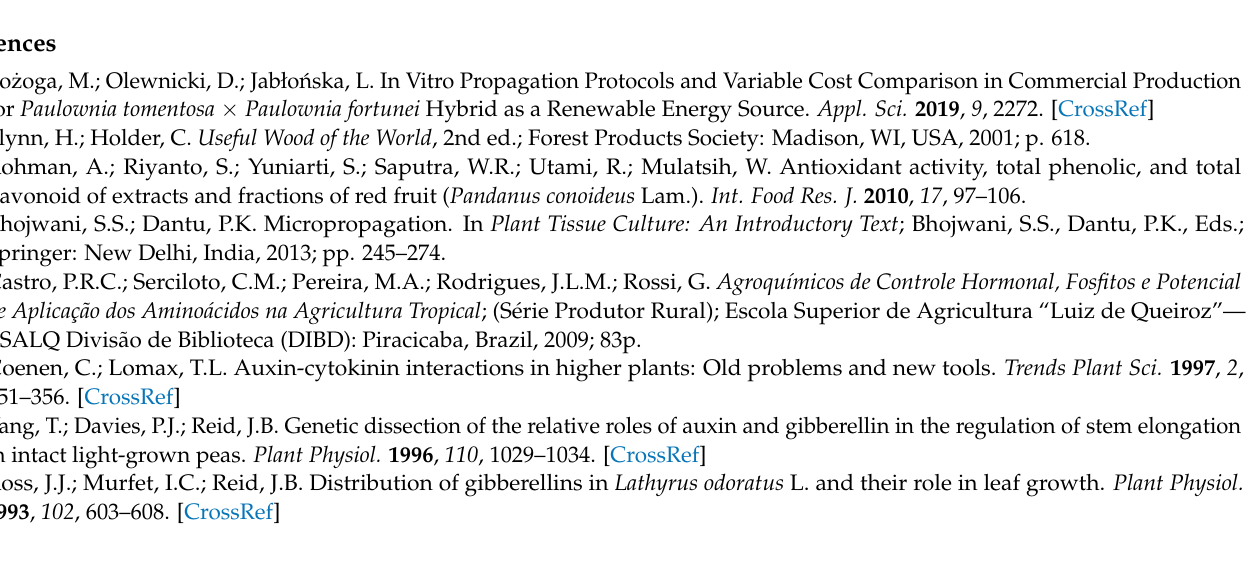
ladder.; Figure S6. ISSR-PCR amplification patterns obtained from different primers of five